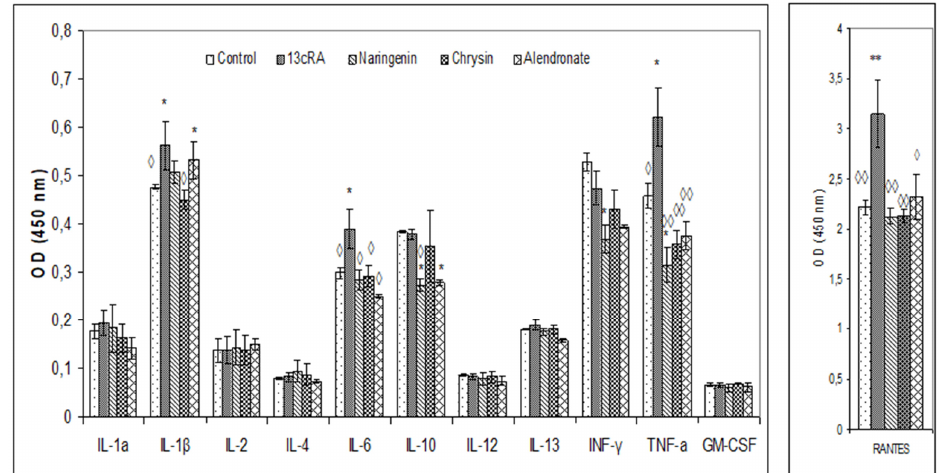
Figure 7. Effects of naringenin, chrysin, or alendronate on cytokine levels in rats with retinoic-acid- induced osteoporosis. Rats were administered ig with retinoic acid (13cRA) suspension (80 mg/kg) once daily for 14 days. After inducing osteoporosis with 13cRA, rats were administered ig with naringenin (100 mg/kg), chrysin (100 mg/kg), or alendronate (40 mg/kg), once daily for the next 14 days. Results are expressed as means of three samples per group ( n = 3) ± SEM. Data were analysed by the Kruskal–Wallis test. *—Statistically significant compared with control (* p < 0.05; ♦ ♦ p ♦♦ p ** p < 0.01) —Statistically significant compared with 13cRA ( < 0.05; < 0.01).